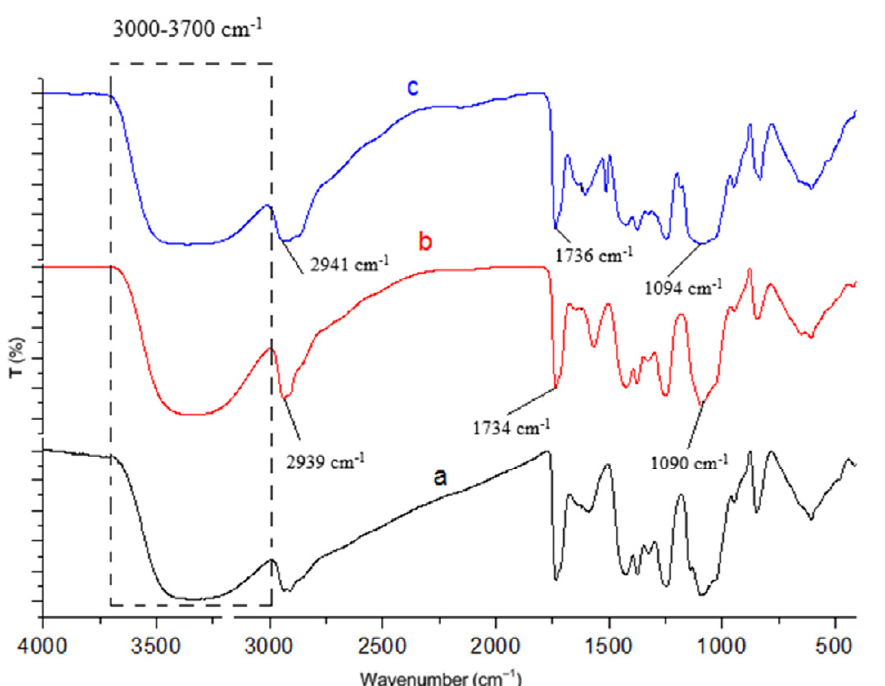
Fig. 6. FTIR spectrum of (a) PVA/CS/ CeAlO